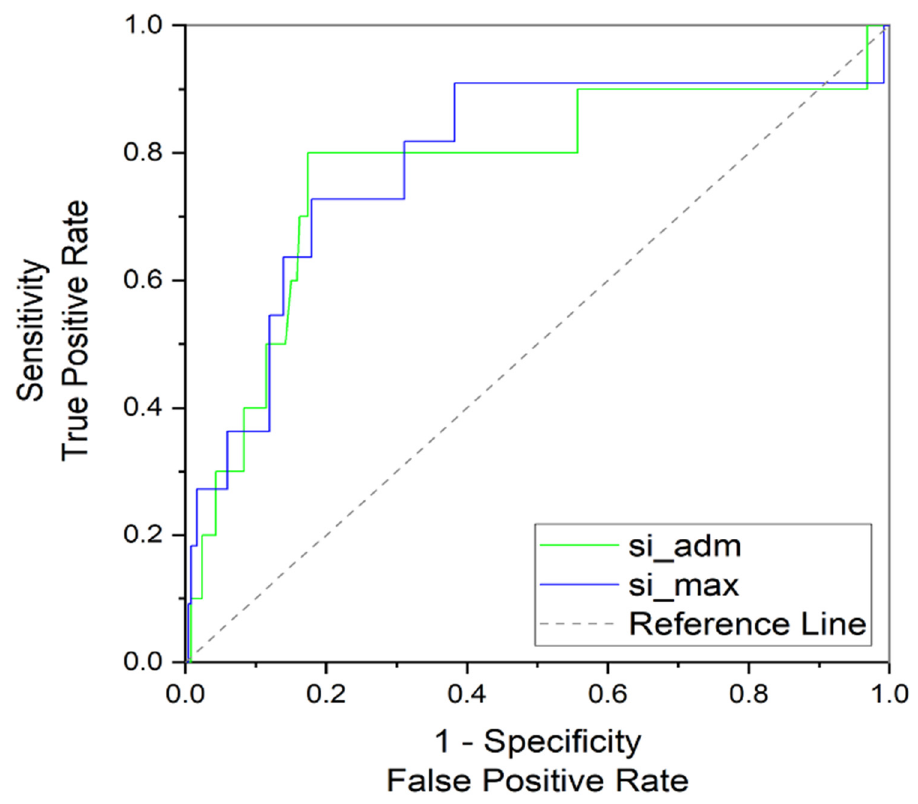
Figure 2. Receiver operating characteristics curve for severe hypofibrinogenemia and worst prehospital (si_max) and admission (si_adm) shock index.